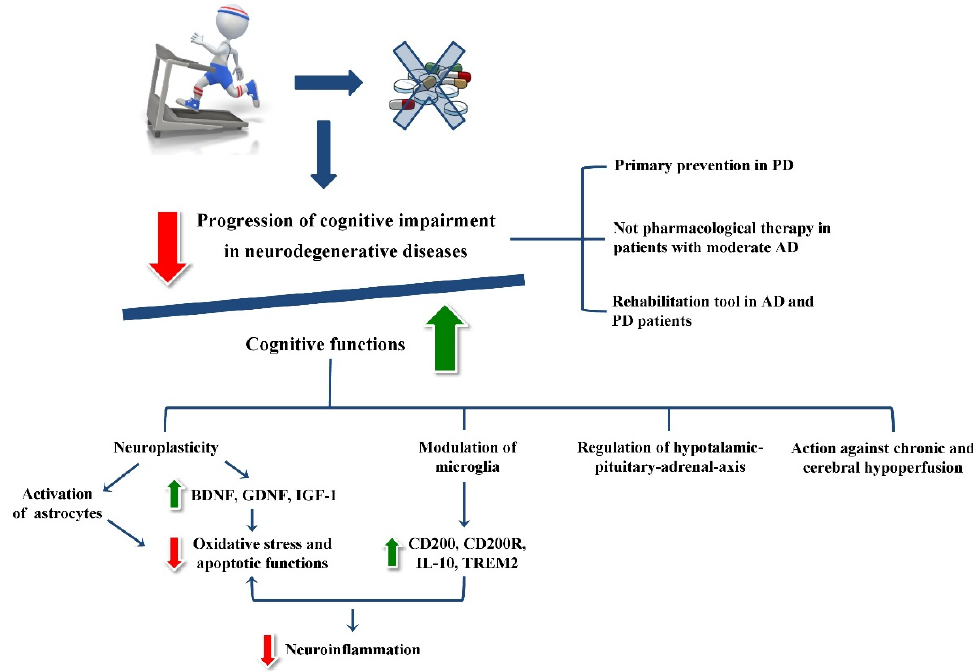
Figure 1. A graphic scheme of all the clinical and neurobiological effects of physical exercise.